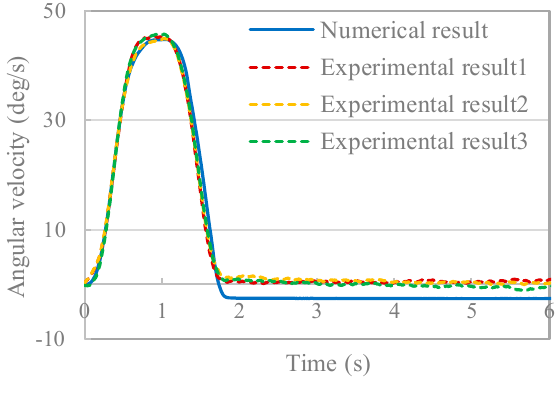
Figure 9. Time history of angular velocity.